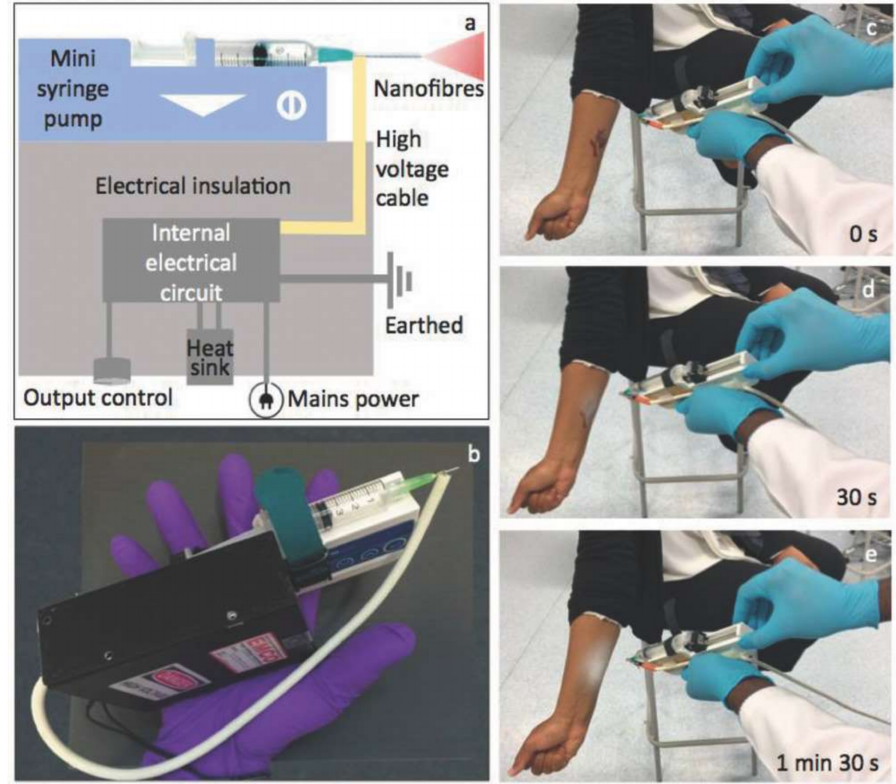
Figure 9. ( a ) Schematic diagram of the portable EHD device. ( b ) A photograph showing the assembly of the mini device held in hand. ( c – e ) Snapshots of real-time recording of the operation of the mini EHD device generating nanofibers onto a mock wound in situ [188] (Reproduced CC BY